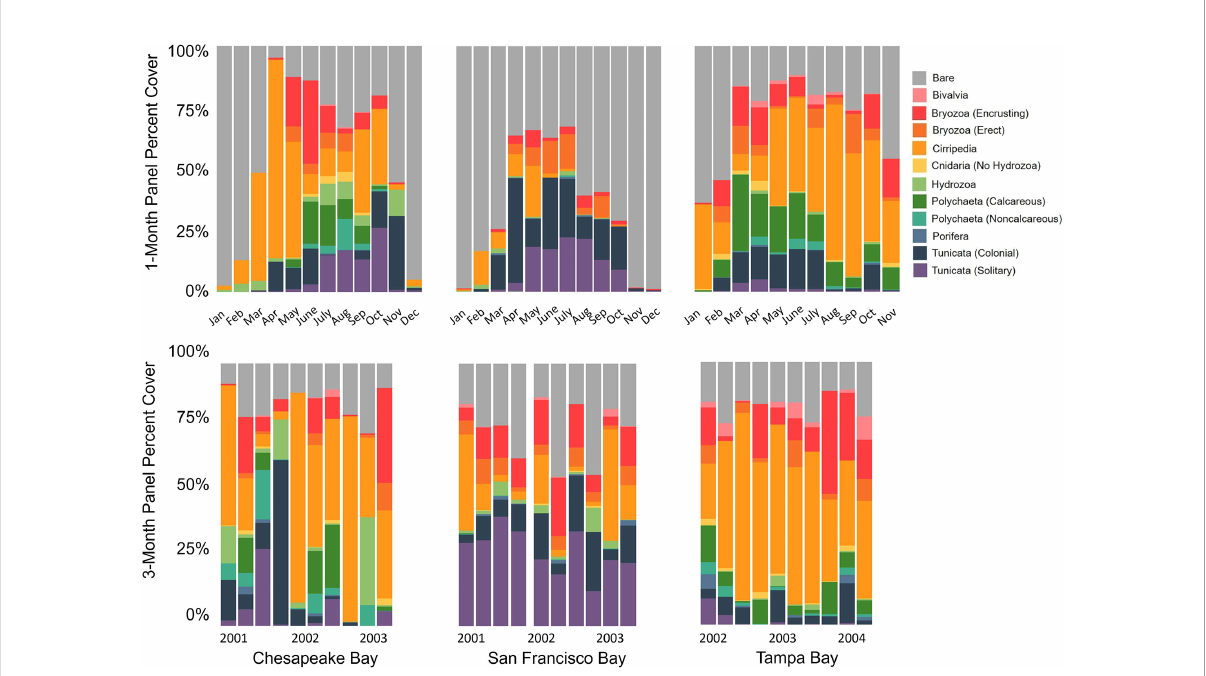
FIGURE 4 Average percent cover of 1-month (top) and 3-month (bottom) panels deployed over the course of period 1 in Chesapeake Bay, San Francisco Bay, and Tampa Bay (see Table 1 for deployment and retrieval